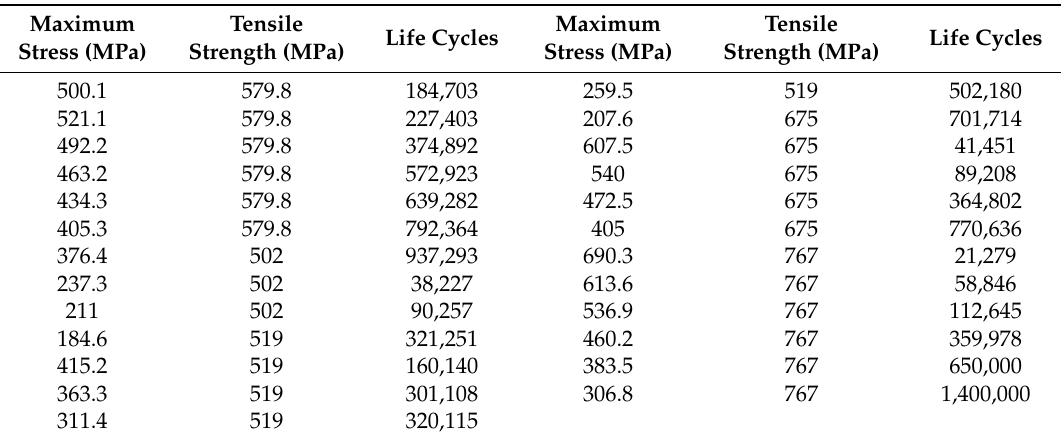
Table 6. Training data for fatigue life